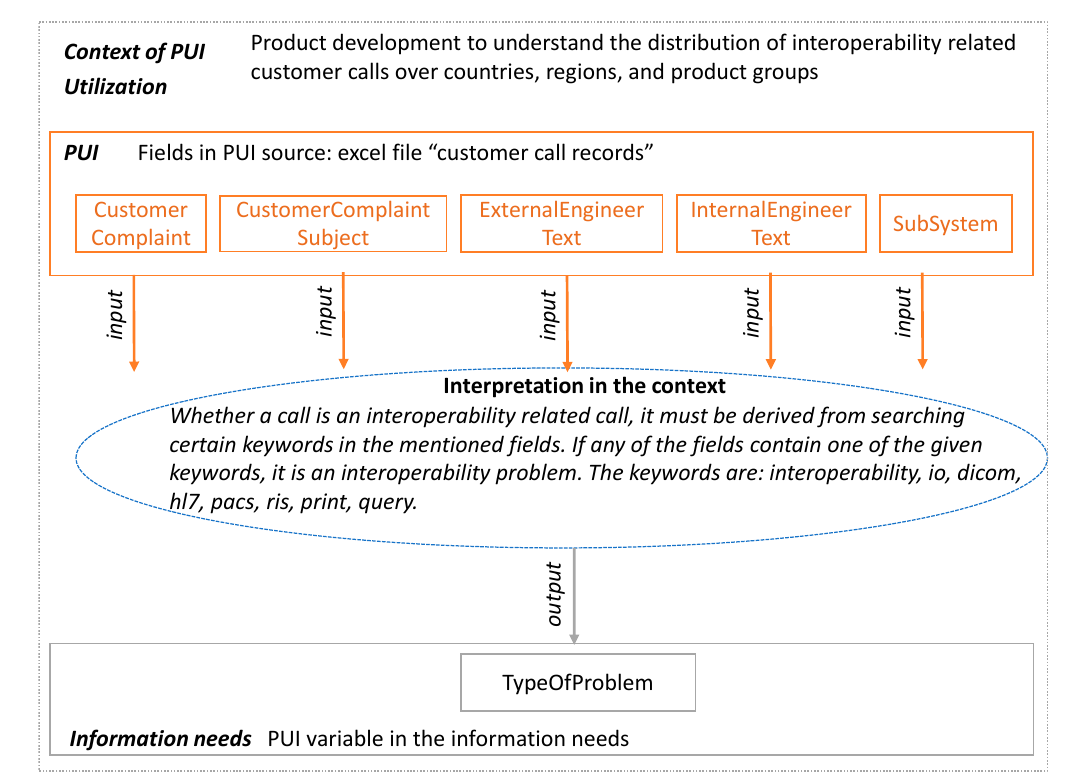
Figure 9. Context-based interpretation for the information needs ‘typeOfProblem’.